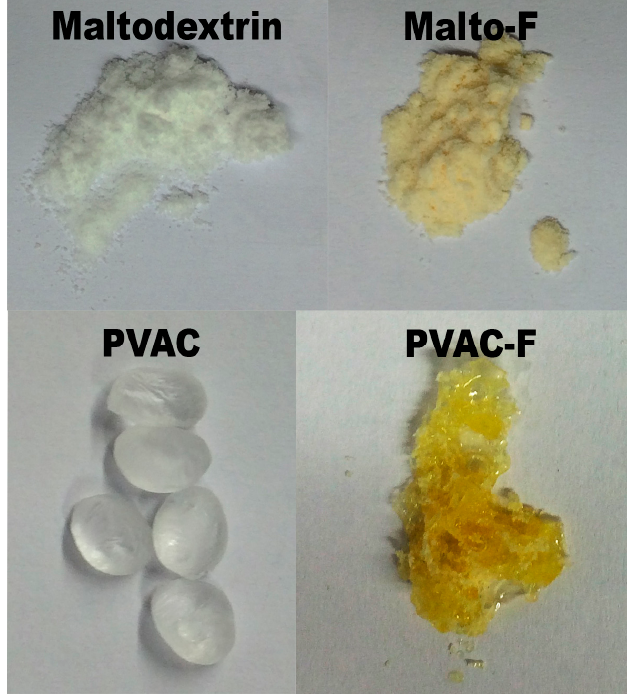
Figure 5. Color changes of Malto-F (soluble filtrate) and PVAC-F after reaction.